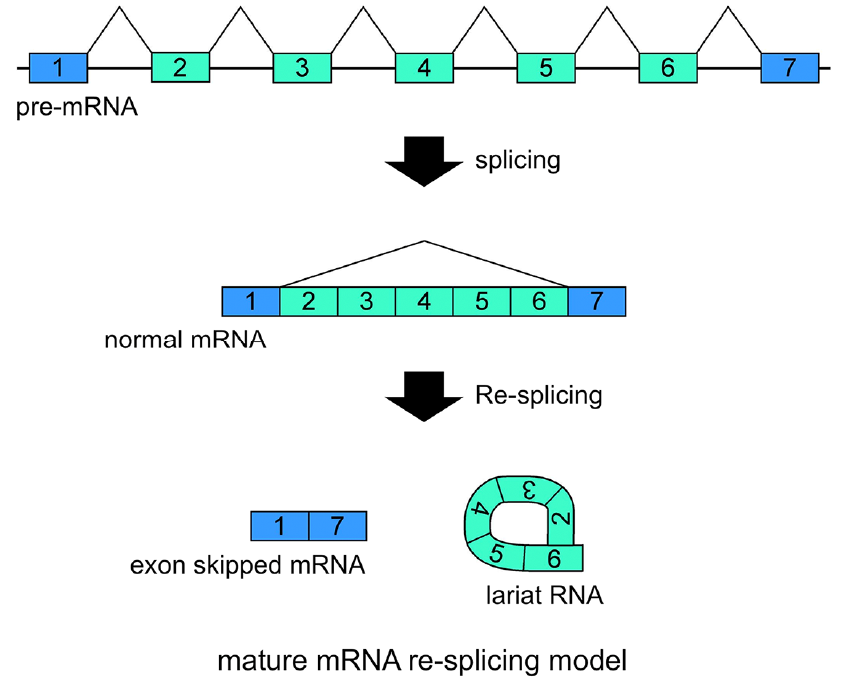
Figure 3. Schematic representation of the mature mRNA re-splicing model. Correlated expressions of exon skipped mRNA and exonic lariat RNA (lariat exon) indicated that this splicing model operates for the TSG101 (tumor susceptibility gene 101) and FHIT (fragile histidine triad protein) genes [37]. The first splicing conventionally generates normal mRNA. Although the spliced products are not usually involved in additional splicing processes, normal TSG101 and FHIT mRNAs are probably involved in the second splicing events. Re-splicing of mature mRNA produces multiple exon skipped mRNAs and exonic lariat